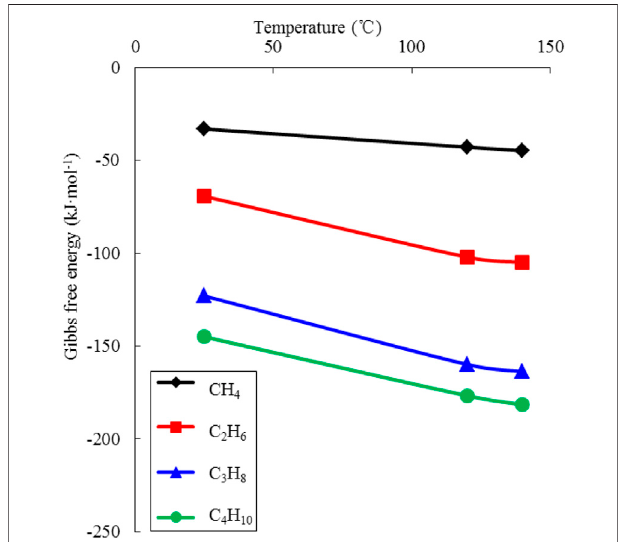
FIGURE 13 | The Gibbs free energy of C 2 H 6 to C 4 H 10 during TSR at different temperatures.